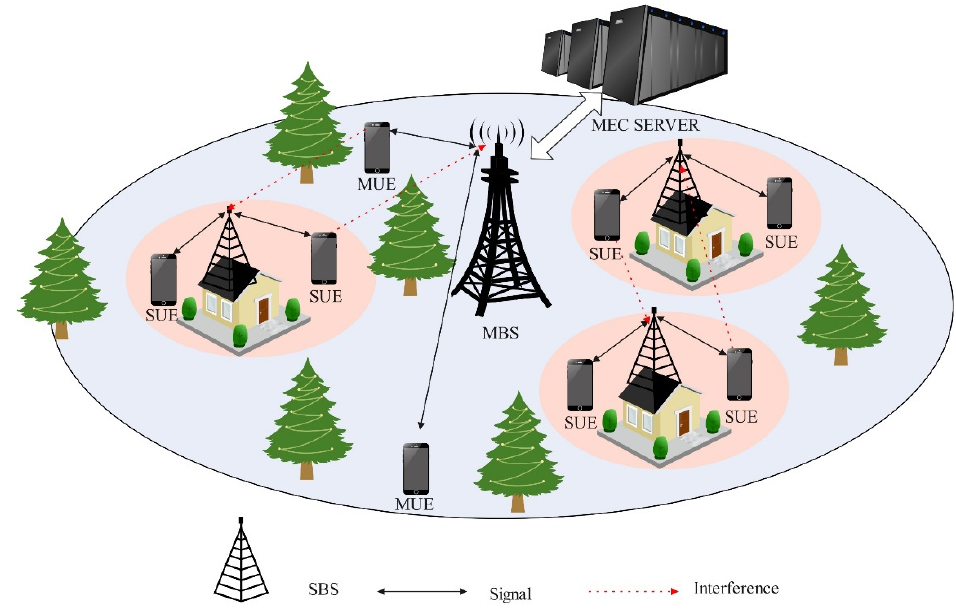
Figure 12. Interferences in UDNs Scenario.